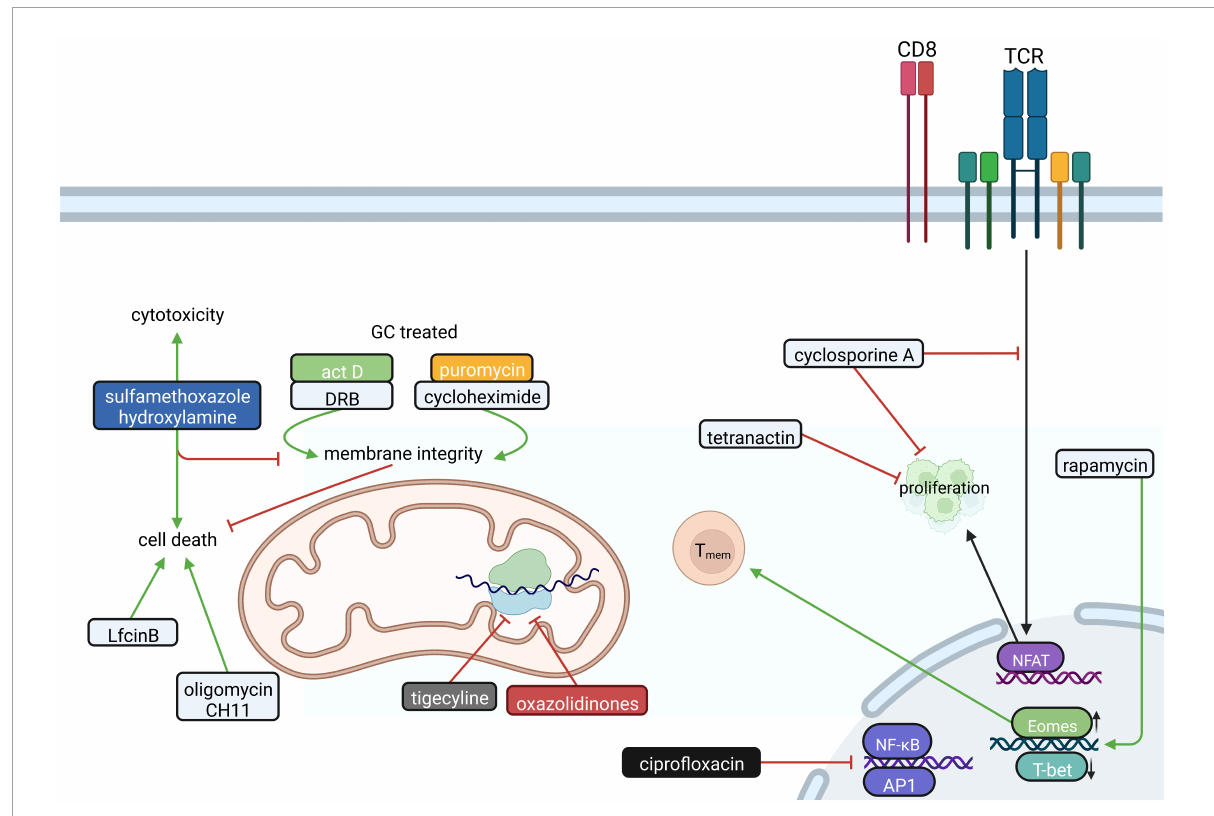
FIGURE3 The influence of antibiotics on CD8 + T cells. In CD8 + T cells antibiotics like tetranactin and cyclosporin A interfere with proliferation by inhibiting the transcription factor NFAT. Additionally, many antibiotics influence mitochondrial function in CD8 + T cells. Actinomycin D (Act D), daunorubicin (DRB), cycloheximide and puromycin impair the glucocorticoid (GC)-induced loss of mitochondrial membrane integrity, which prevents cell death in CD4 + CD8 + thymocytes. Sulfamethoxazole hydroxylamine, in turn, amplifies apoptosis and is relevant for CTL-mediated cytotoxicity. Furthermore, the attenuation of the mitochondrial membrane potential by Oligomycin and CH11 or activation of the intrinsic mitochondrial apoptosis pathway by bovine lactoferricin (LfcinB) lead to cell death. Furthermore, oxazolidinones and tigecycline interfere with mitochondrial function in CD8 + T cells by inhibiting mitochondrial protein translation. The fluoroquinolone ciprofloxacin suppresses the induction of transcription factors NF- κ B and AP-1, while Rapamycin favors to the generation of CD8 + T memory cells (T mem ). Created with